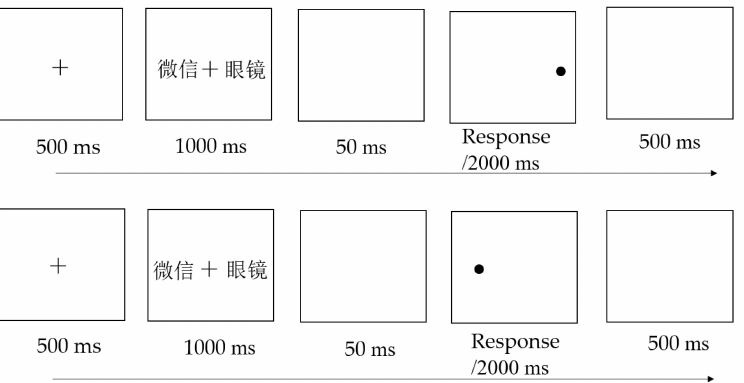
Figure 2. The timeline of the addiction DPT. Note: 微信 = WeChat, 眼镜 = glasses. Index of AB = mean RT of congruent trials − mean RT of incongruent